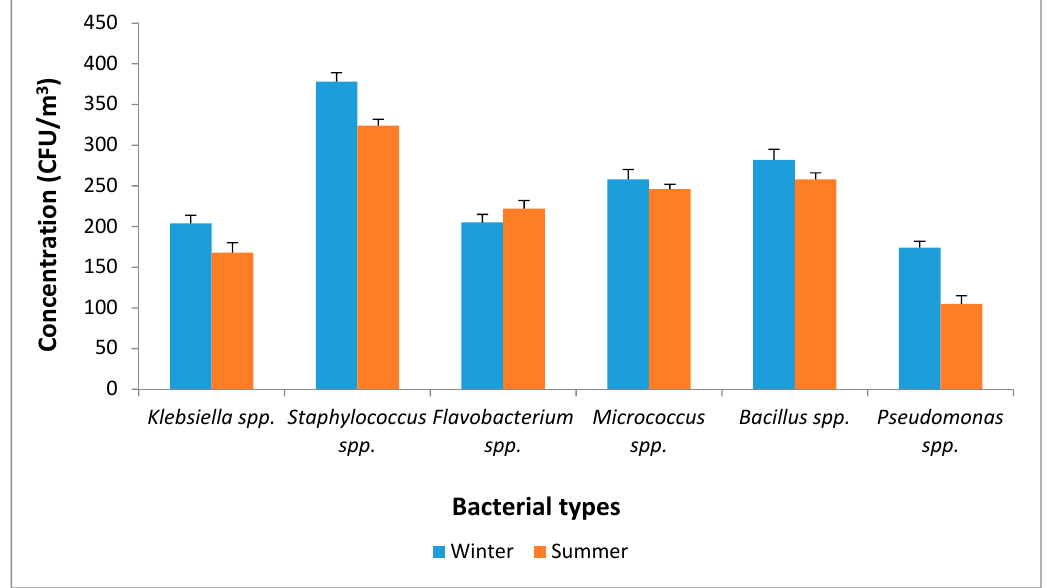
Figure 4. Concentration of isolated bacterial ‐ bound PM 2.5 in Pretoria West.